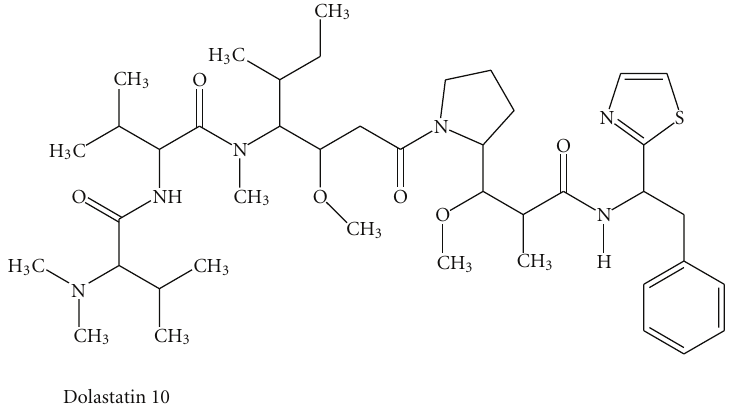
Figure 2: Structure of dolastatin 10.